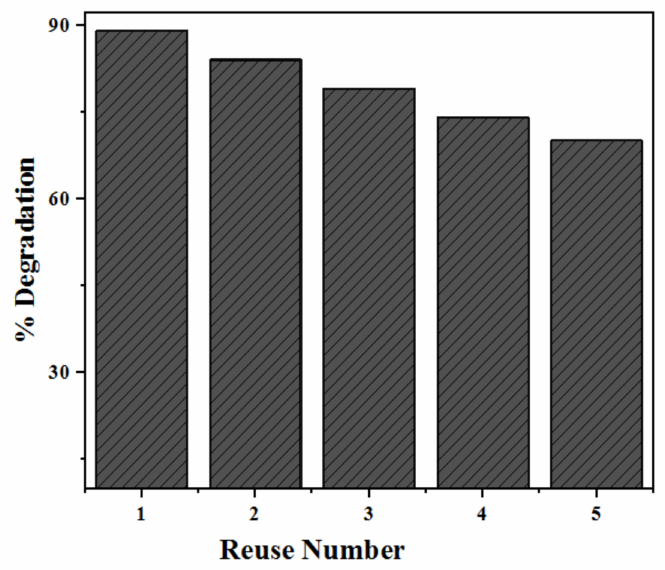
Figure 17. Recycling performance of Mn 2+ :ZnS Qds over multiple cycles on sonophotocatalytic degradation of